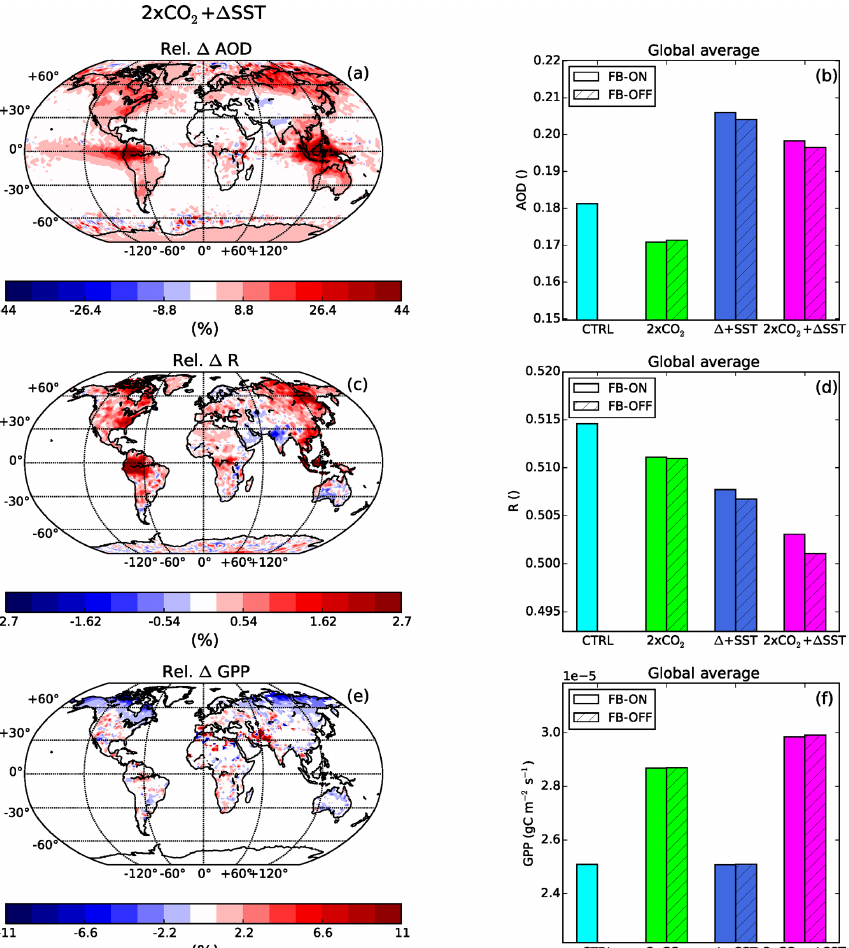
Figure 9. The relative difference between the FB-ON and FB-OFF simulations in the annually average AOD (a) , R (c) and GPP (e) for the 2 × CO 2 + (cid:49) SST experiment. In the bar plots (b, d, f) , the globally averaged values of the same variables are shown for the CTRL simulation as well as the three experiments (both FB-ON and FB-OFF